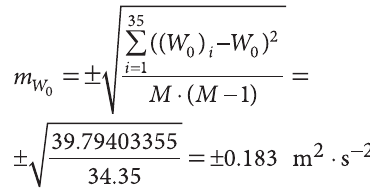
Table 1. Determination of the best fitting value W